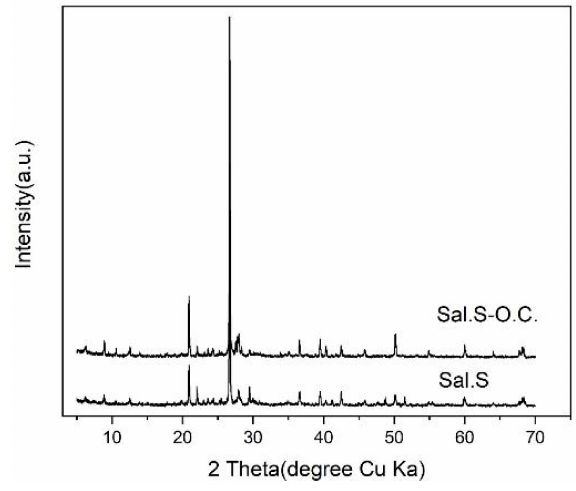
Figure 2. XRD patterns of SASs (Sal.S.) and organic-free SAS